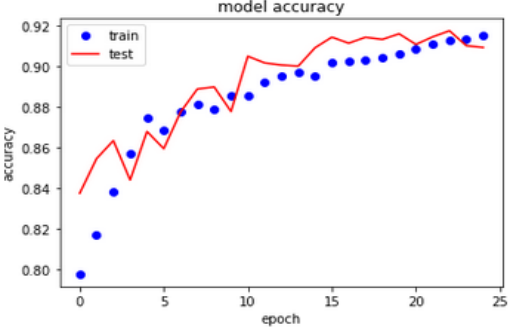
Fig.13: A plot of accuracy on the training and validation datasets over training epochs.